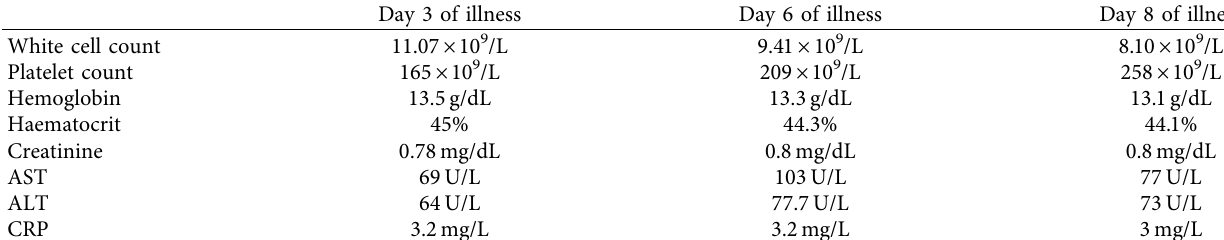
Table 2: Laboratory investigations.